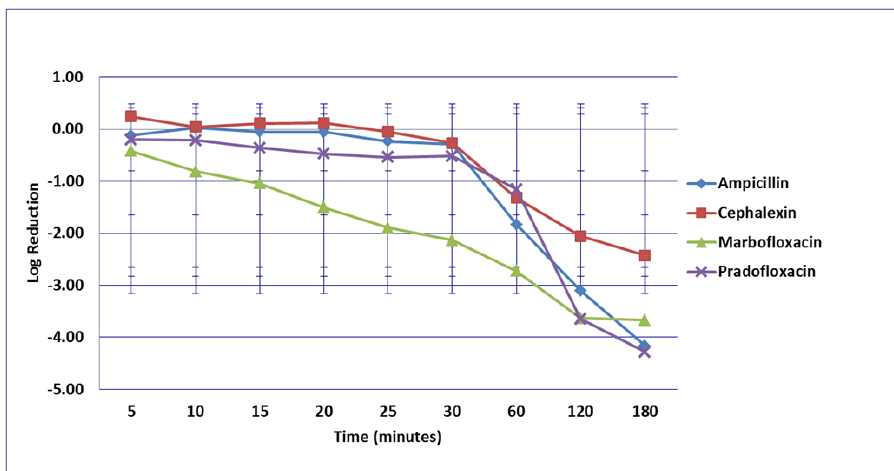
Figure 9. Log 10 reduction in P. mirabilis with bacterial cells exposed to ampicillin, cephalexin, marbofloxacin, pradofloxacin, and trimethoprim/sulfamethoxazole at the minimum inhibitory drug concentration. Data points present mean ± standard deviation.